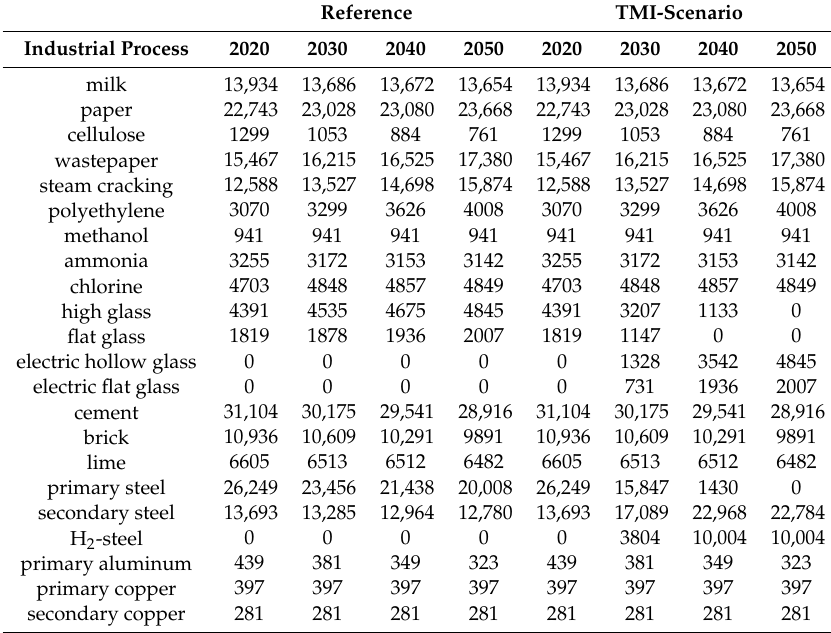
Table A4. Production volume of processes in Reference and TMI scenarios between 2020 and